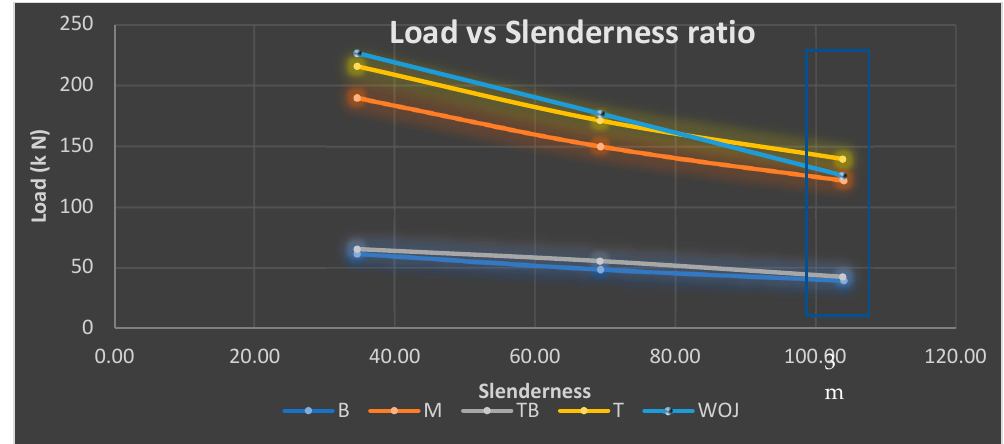
Figure 16. Comparison of capacity load of TDGLC + TG vs. TDGLC without Joint.